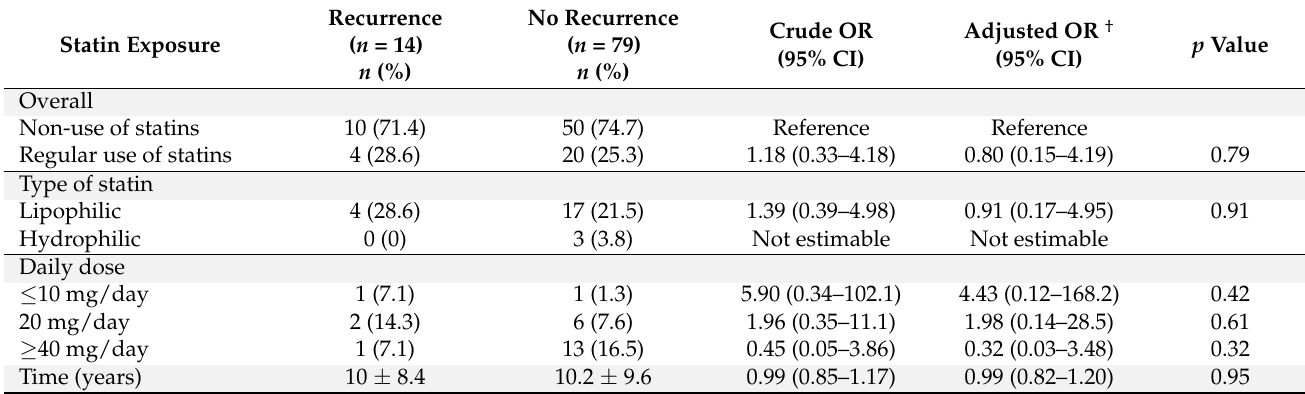
Figure 1. Adjusted OR for the association between statin exposure and head and neck cancer risk according to topographic location (Head and neck: OR = 0.72, 95% CI 0.28–1.84 ( p = 0.49); Oral cavity: OR = 0.98, 95% CI 0.34–2.86 ( p = 0.97); Oro/Hypopharynx: OR = 0.94, 95%CI 0.22–4.08 ( p = 0.93); Nasopharynx: OR = 0.28, 95% CI 0.02–4.36 ( p = 0.36); Larynx: OR = 0.69, 95% CI 0.19–2.51 ( p = 0.57)). 2.4. Association between Prior Use of Statins and Recurrence of Head and Neck Cancer Statins exposure was similar between patients with recurrence of head and neck cancer (28.6%) and patients without recurrence of the disease (25.3%) (Table 5). Similar trends were found when exploring by type of statin and by time of statin use. Patients without recurrence of head and neck cancer were more likely to use higher doses of statins than patients with recurrence of the disease (16.5% vs. 7.1%, respectively) (Table 5). The adjusted logistic regression models showed that prior use of statins was not associated with a lower recurrence rate of head and neck cancer (OR = 0.80; 95% CI 0.15–4.19). Lipophilic statin use was also not associated with a lower recurrence rate (OR = 0.91; 95% CI 0.17–4.95). The effect of hydrophilic statins could not be assessed, as no patients with recurrence of head and neck cancer were taking hydrophilic statins. There was also no dose- and/or time-dependent association between statin exposure and recurrence of head and neck cancer (Table 5). Table 5. Association between statin exposure and recurrence of head and neck cancer.